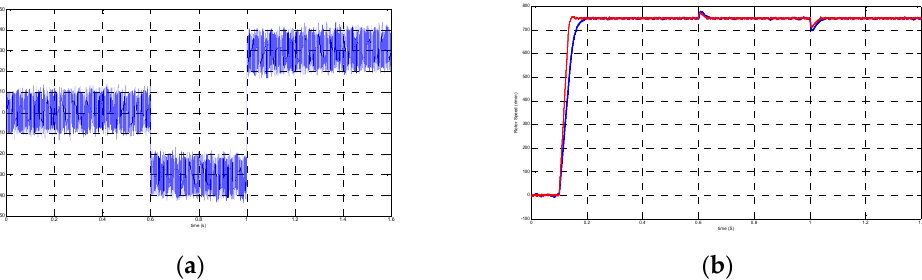
Figure 5. Numerical simulation results of different control. ( a ) Load signal; ( b ) the rotor speed response of the PMSM.